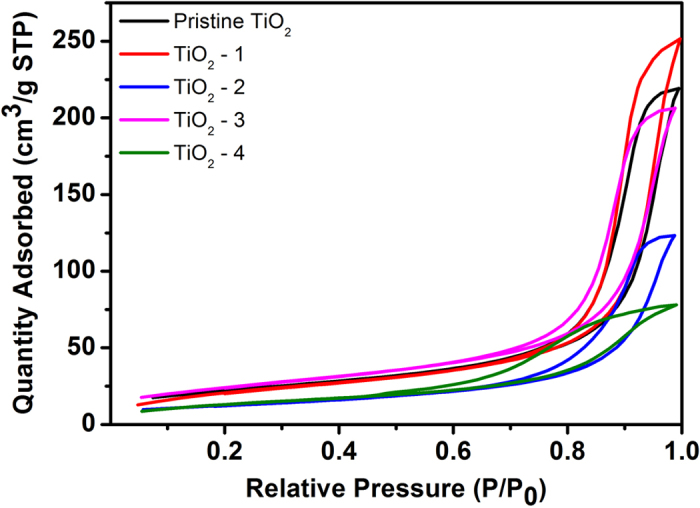
N2 adsorption-desorption isotherms for pristine TiO2 and as-obtained TiO2.